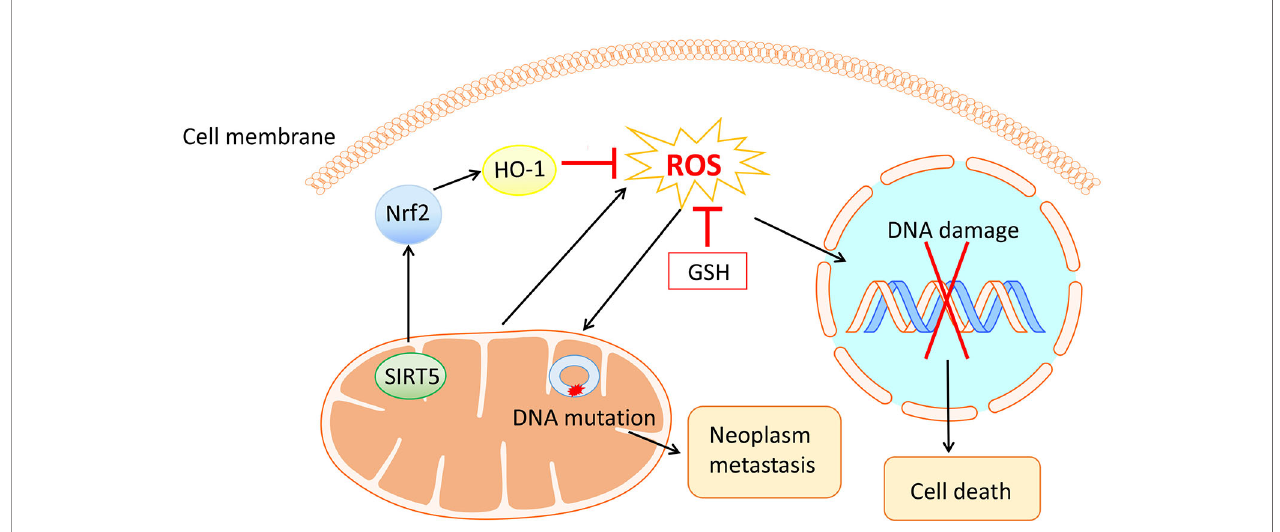
FIGURE 1 | The mitochondria generated ROS and their contradictory effects in ovarian cancer cells. On the one hand, ROS cause DNA damage and thus lead to cell death. On the other hand, ROS bring about mitochondrial DNA mutation, encouraging neoplasm metastasis. Antioxidative systems including GSH and Nrf2 with their upstream and downstream molecules have antagonistic effects on